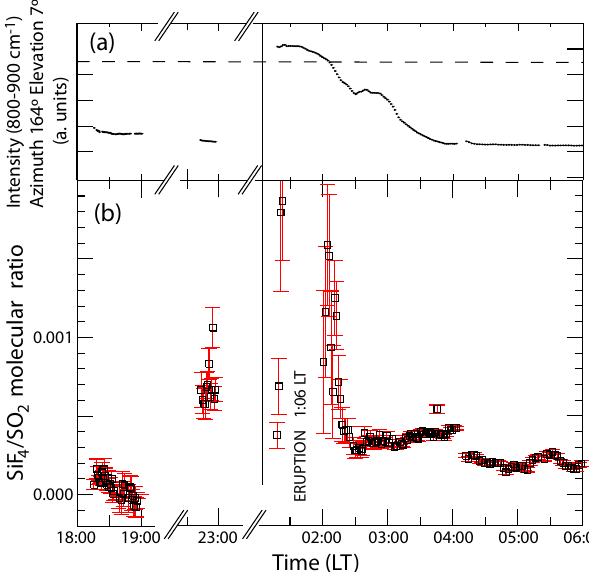
Fig. 13. Time-series of (a) the integrated radiation collected from above the crater and (b) the SiF 4 /SO 2 molecular ratio (squares) before and after the eruptive event that took place between 01:06 and 01:45LT of 17 November 2008. The dashed line indicates the threshold chosen to filter-out data for calculating molecular